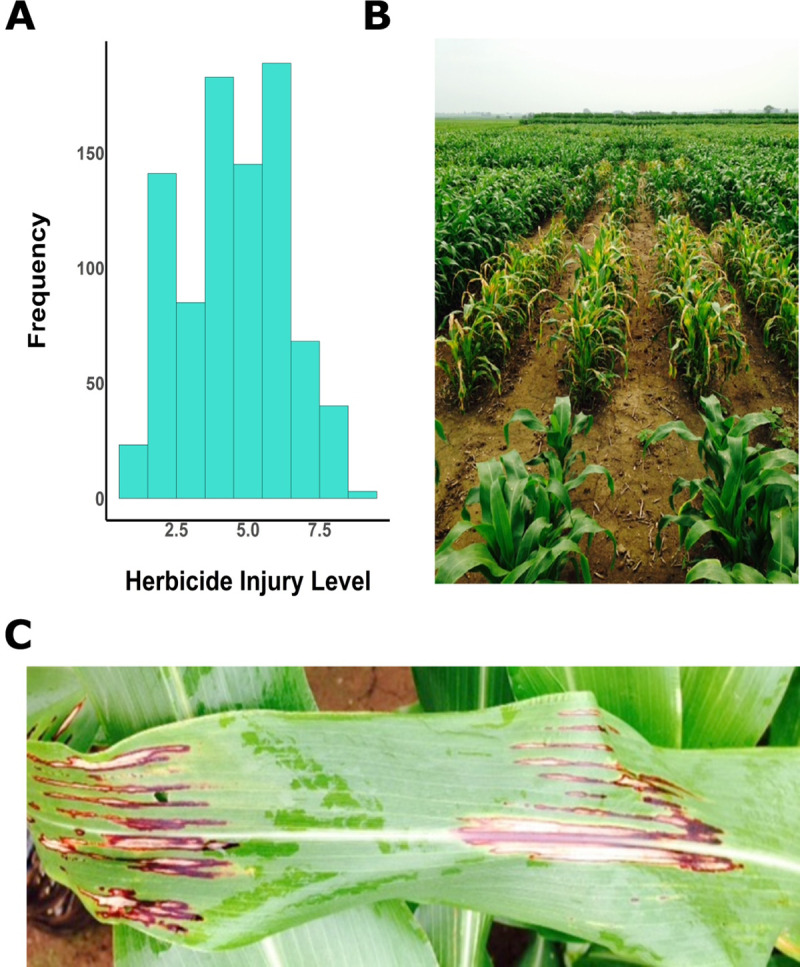
Field-based phenotypic variation.Phenotypic distribution (A) and phenotypes (B and C) of herbicide injury in the sorghum biomass panel during the 2015 field season.